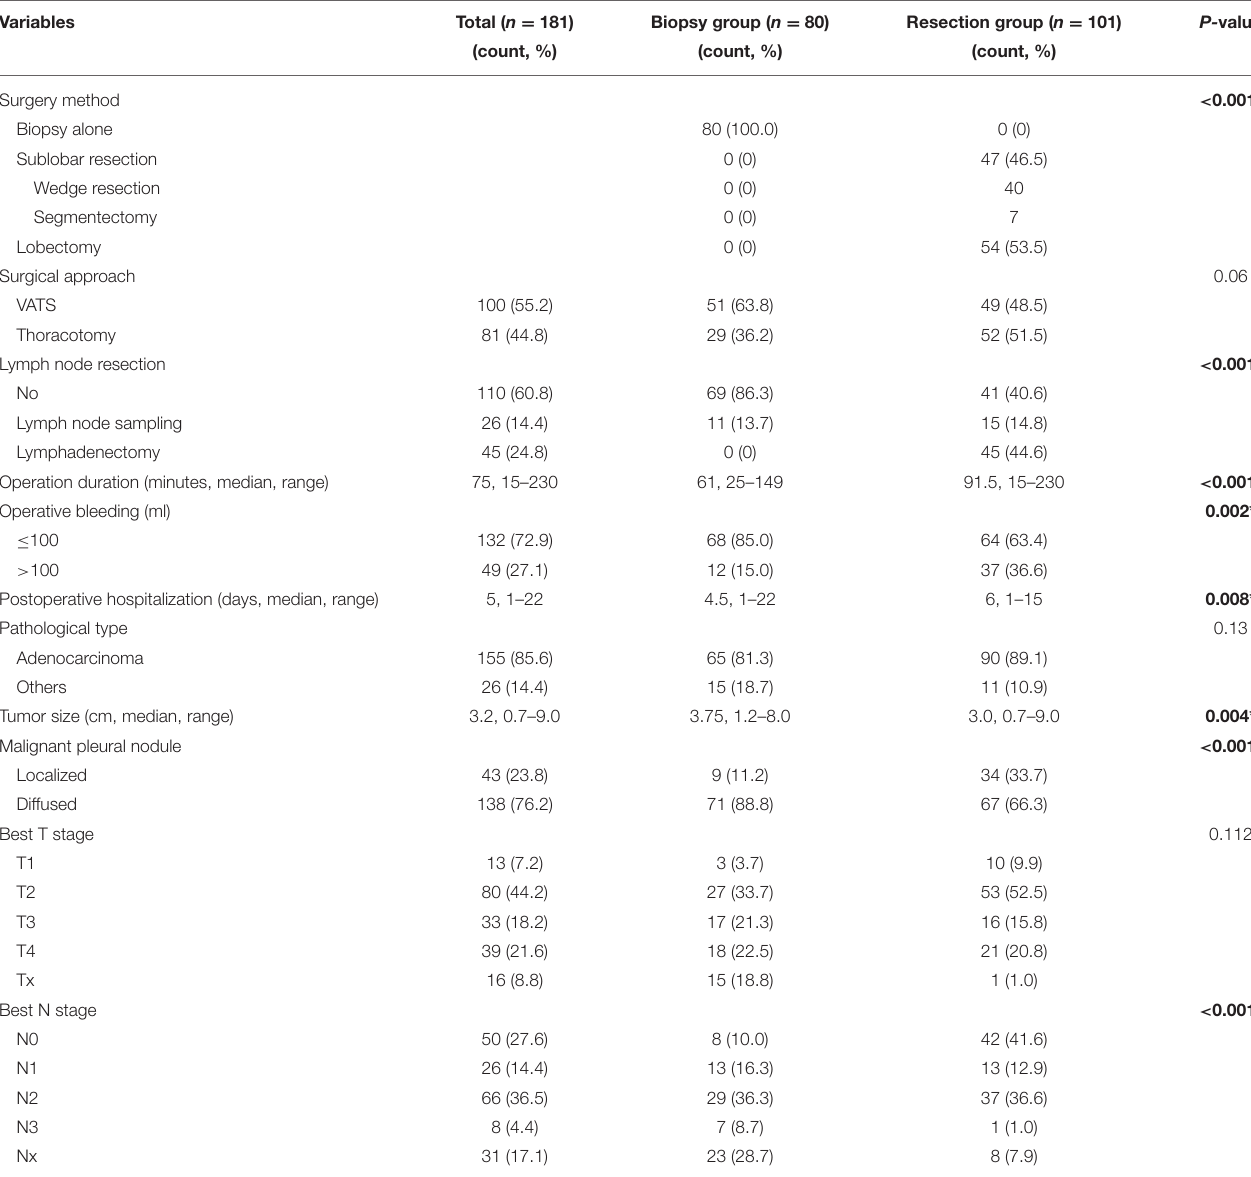
TABLE 2 | Operative and pathological findings of pleural biopsy group and primary tumor resection group. Variables Total ( n = 181) Biopsy group ( n = 80) Resection group ( n =